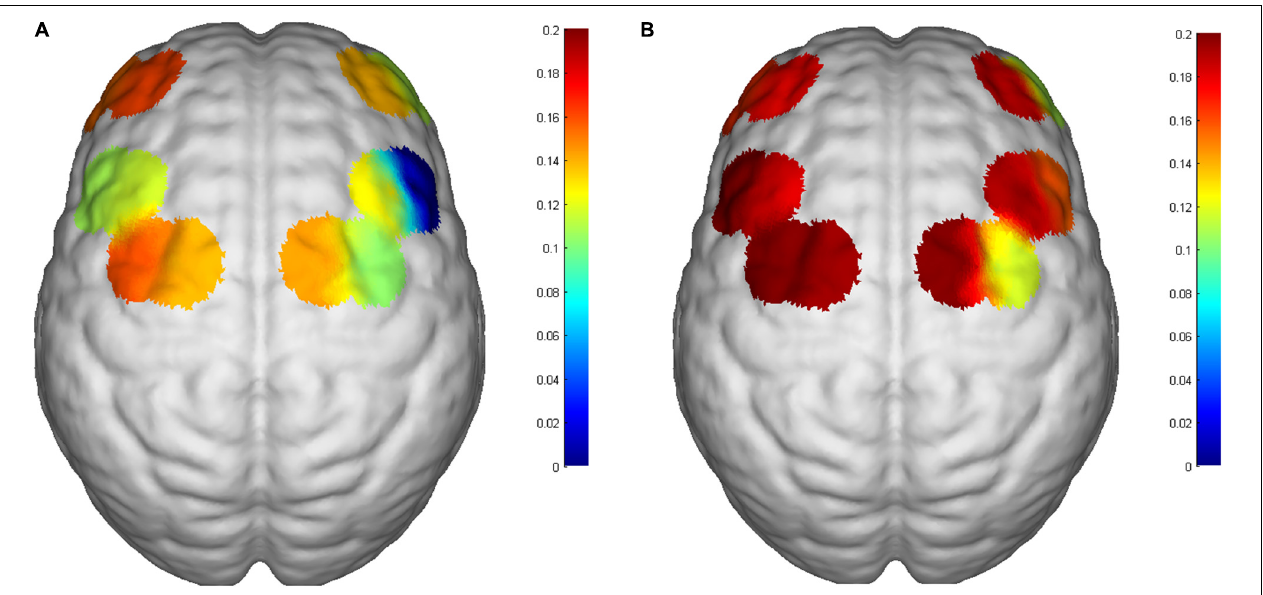
FIGURE 5 | Changes in mean HbO2 of the 6th subject. (A) Before iTBS and (B) post iTBS. Significant activation in the SMA in the post-iTBS phase relative to baseline. The number on the left of the color bar stands for mean HbO2, which means that the larger the mean HbO2 value of a channel, the closer the color is to red; otherwise, the closer it is to